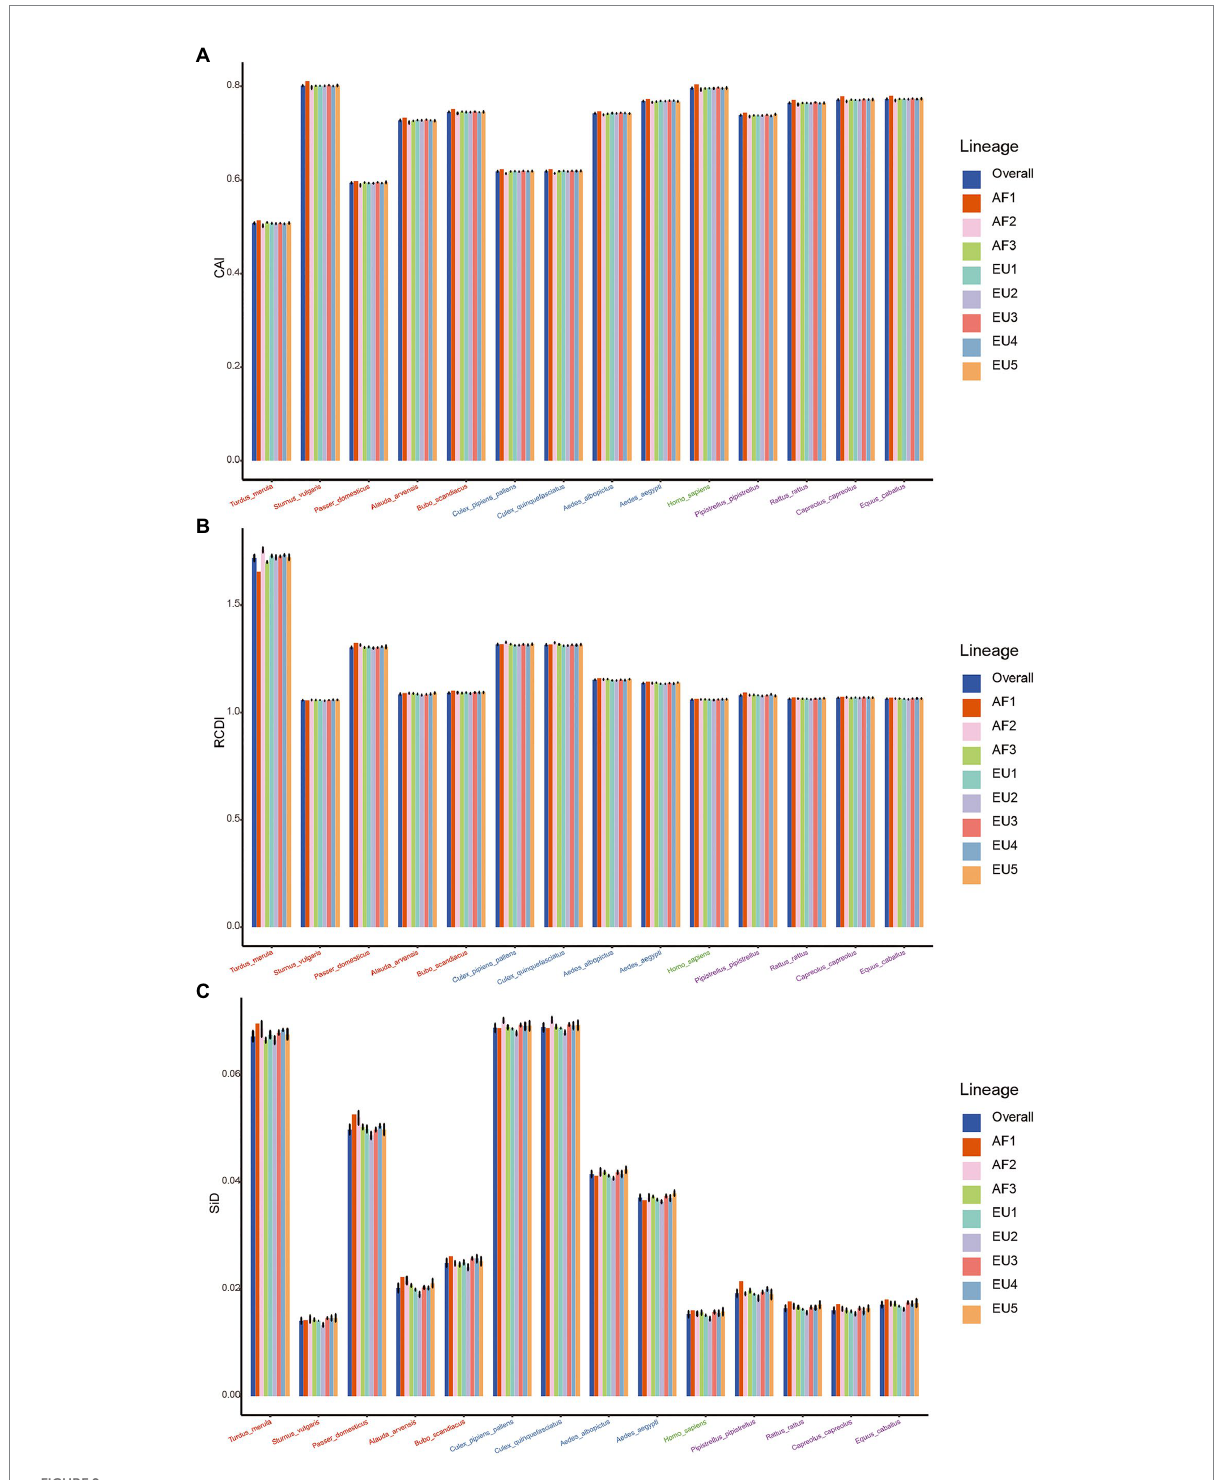
FIGURE 9 The measure of adaption of distinct lineages of USUV to various hosts. (A) CAI, (B) RCDI, and (C) SiD analysis of the codon usage between the complete coding sequences of the USUV and its hosts. Trends in overall and different lineages are depicted in distinct colors. Error bars represent the standard error of the mean